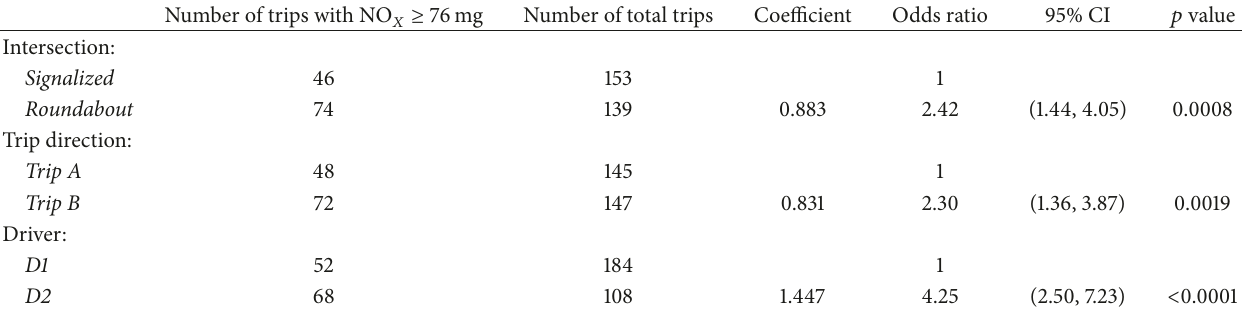
Table 13: Logistic regression relating risk of “high” NO 𝑋 emissions to intersection type, trip direction, and test car driver.